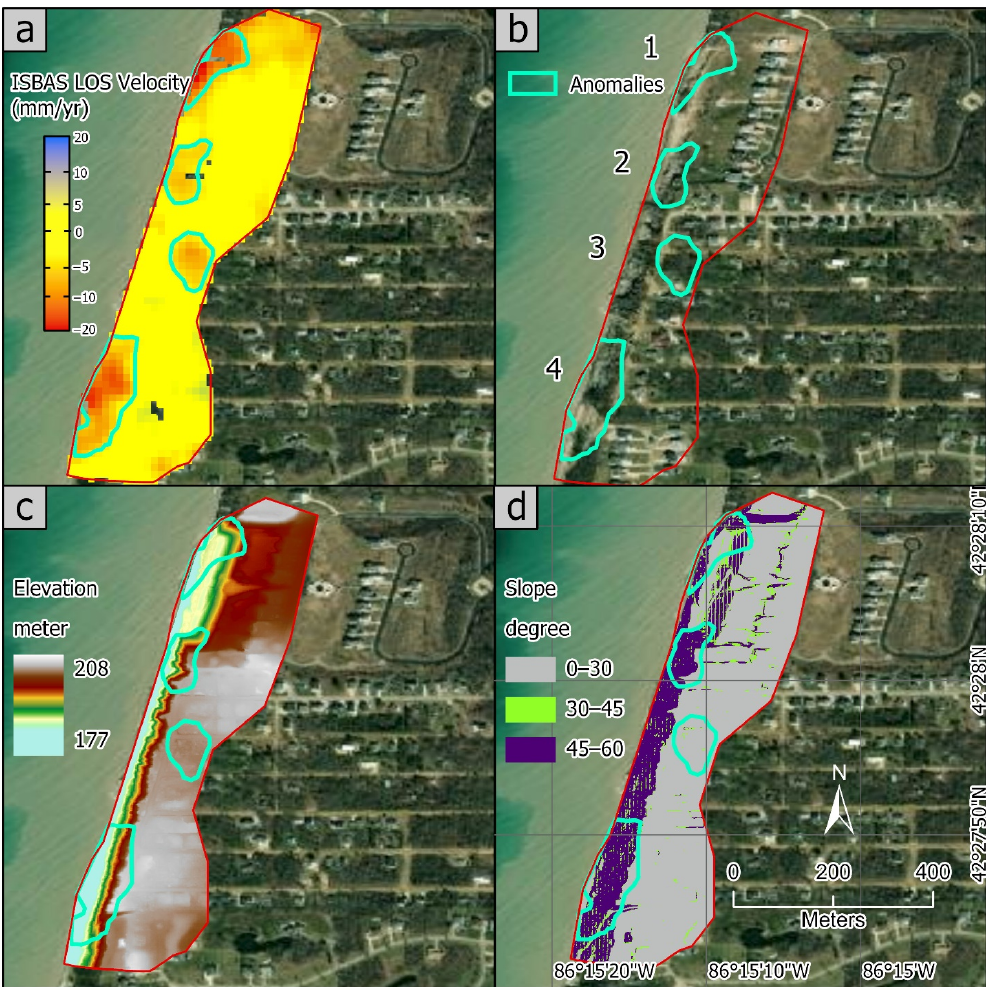
Figure 5. ( a ) ISBAS LOS velocity map over the study area created with a coherence threshold of 0.3 and applying 2D unwrapping methods show movement away ( − 8 to − 21 mm/year) from the satellite in regions occupied by anomalies 1, 2, 3, and 4 (green polygons) in shades of red, surrounded by stable areas with no significant movement (+3 mm/year to − 3 mm/year) in shades of yellow. ( b ) High-resolution (0.5 m) view of an ArcGIS Pro base map over the study area displaying locations of anomalies 1 through 4. ( c ) DEM derived from lidar data [57] (spatial resolution: 1 m), showing the distribution of anomalies 1 through 4, the shoreline, the bluff, and the plateau. ( d ) Slope map derived from lidar DEM showing the steep slopes (45 ◦ –60 ◦ ) of the bluff face. Anomalies 1, 2, and 4 are located on the bluff, whereas anomaly 3 is over the plateau and extends westwards to the upper reach of the bluff. Source of ArcGIS pro base maps in Figure 5a–d: Esri, DigitalGlobe, GeoEye, i-cubed, USDA FSA, USGS, AEX, Getmapping, Aerogrid, IGN, IGP, swisstopo, and the GIS User